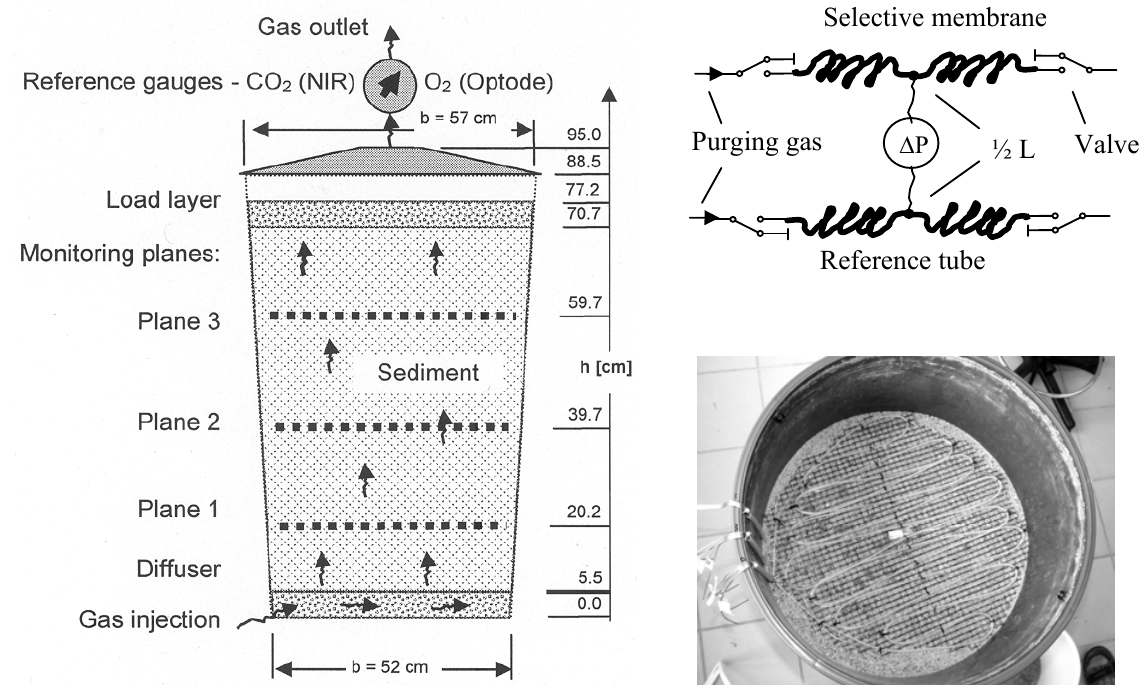
Figure 1. Design of the lysimeter for gas monitoring. Left: sketch of the vertical cross section of the lysimeter. Right: sketch of the selective membrane and the reference tube (top) and top view of the first monitoring plane (bottom) where the tubes are attached to a gauze (1 × 1 cm mashes) to fix their